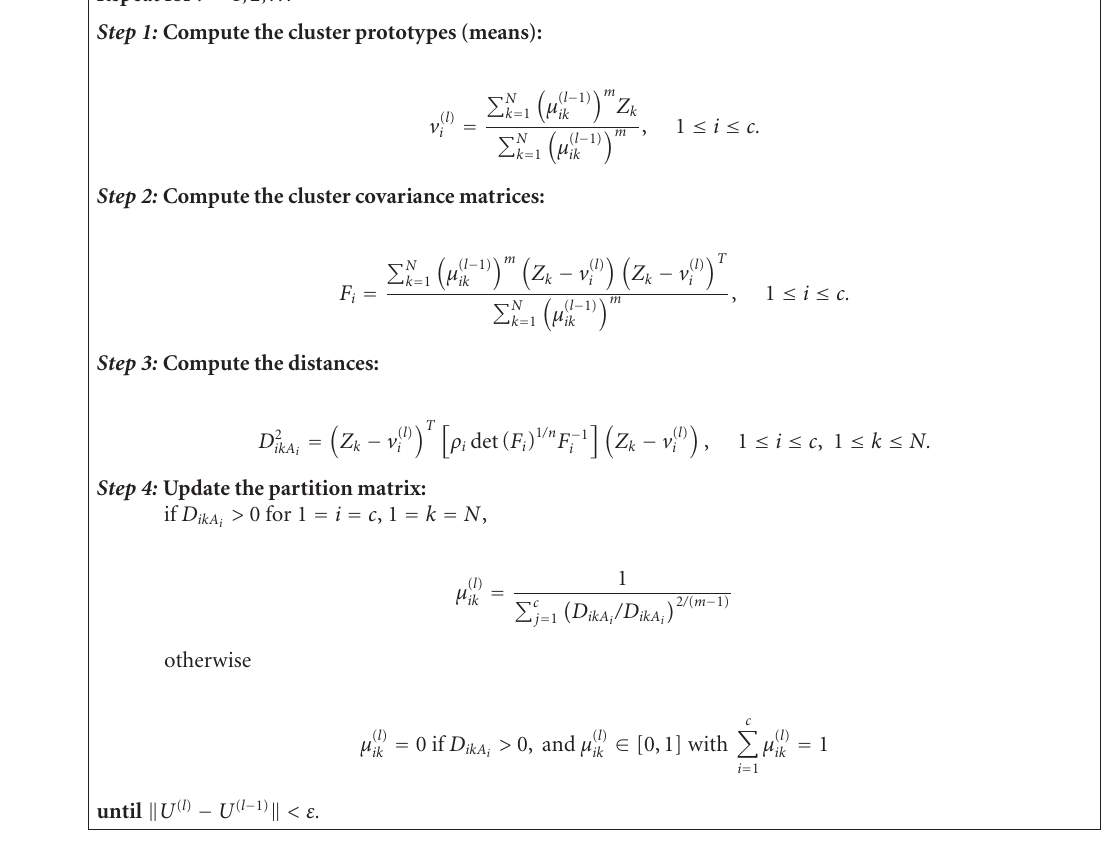
Figure 5: Gustafson-Kessel algorithm from